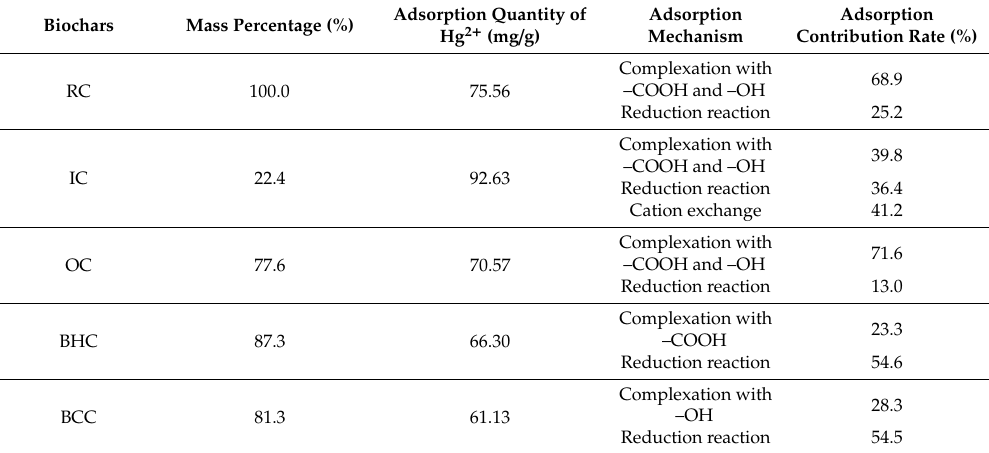
Table 3. Contribution rate (%) and adsorption quantity of Hg 2 + (mg / g) at equilibrium by biochars. Biochars Mass Percentage